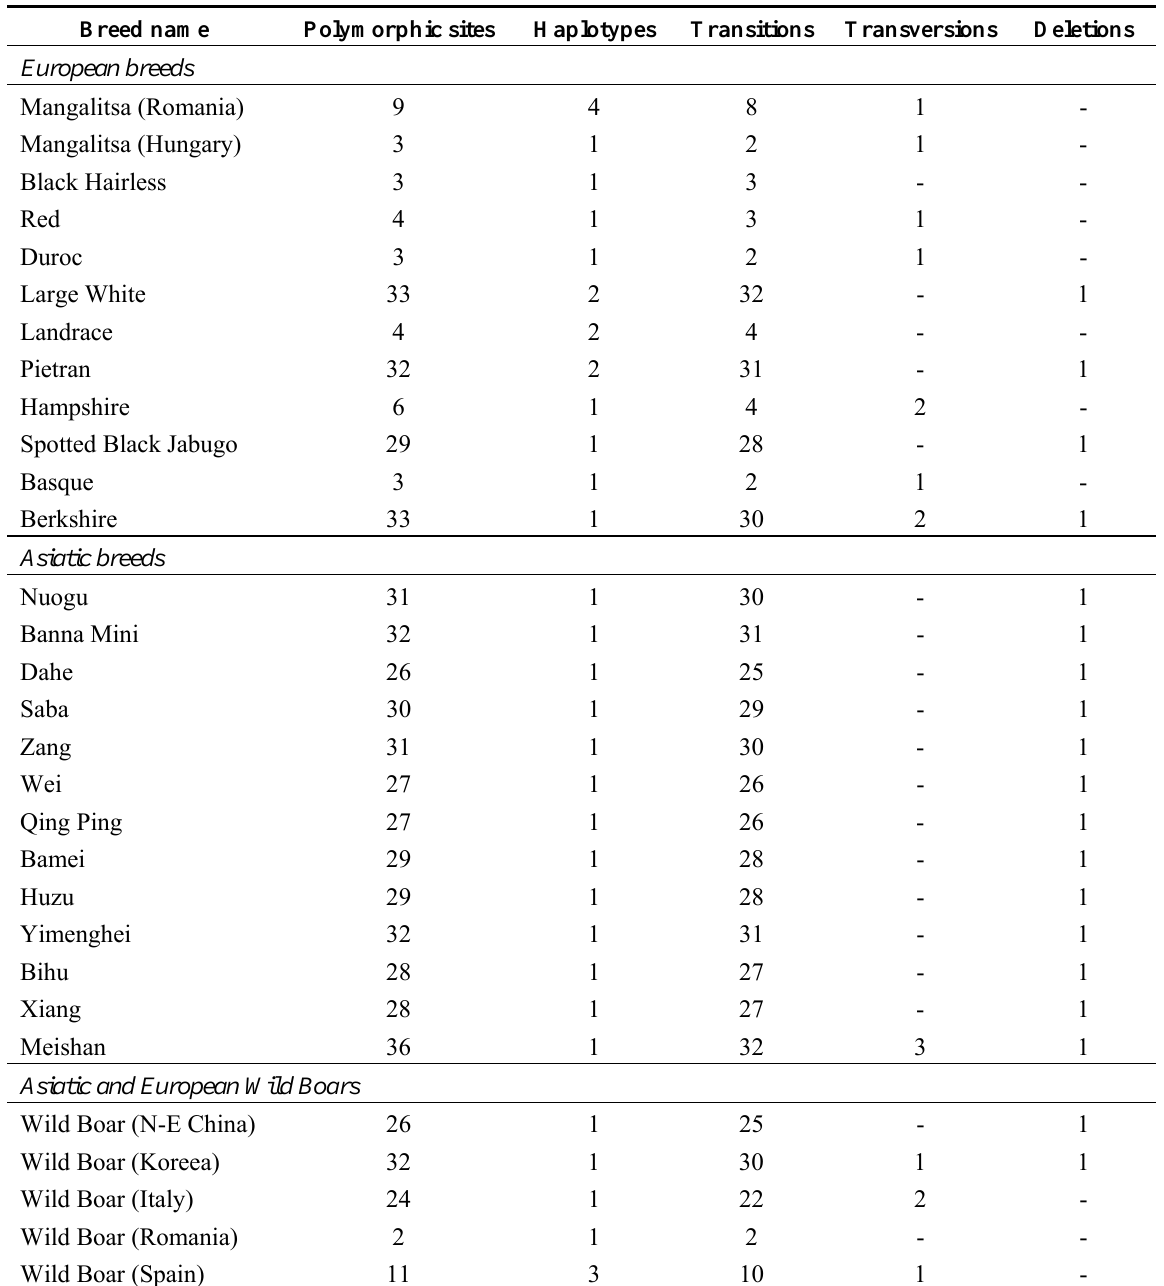
Table 1. Total number of haplotypes and polymorphic sites with their dispersion within 24 different swine breeds and 5 Wild Boar